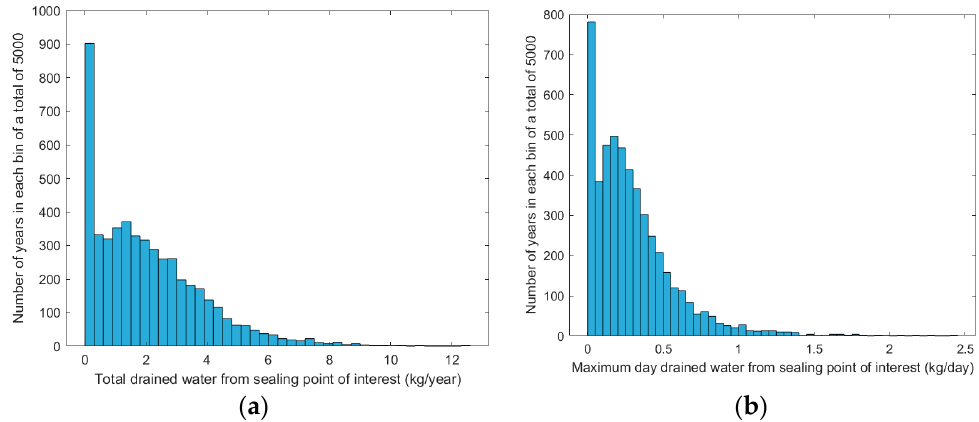
Figure 11. Resulting draining water using assumptions based on [19]: ( a ) total drained water from joint (kg/year); ( b ) yearly day maximum drained water from joint (kg/day).